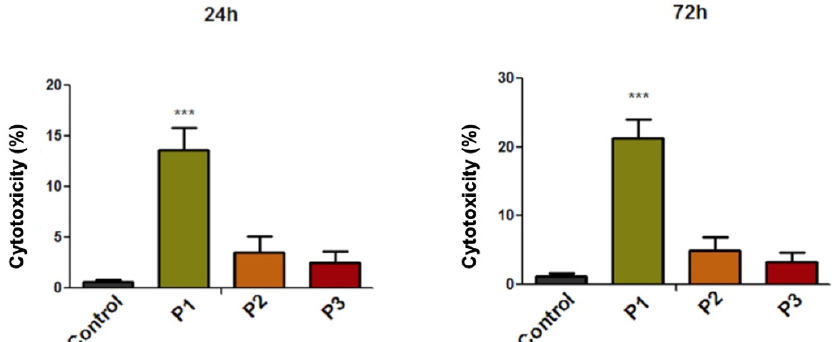
Figure 5. Cytotoxicity percentage of primary human gingival fibroblasts (HGFs) cells at 24 h and 72 h post-treatment with extraction medium of test orthodontic implants (P1, P2, P3). The results represent the mean values ± SD of three separate experiments. One-way ANOVA test was performed to determine the statistical differences followed by Tukey’s multiple comparisons analysis (*** p < 0.001).